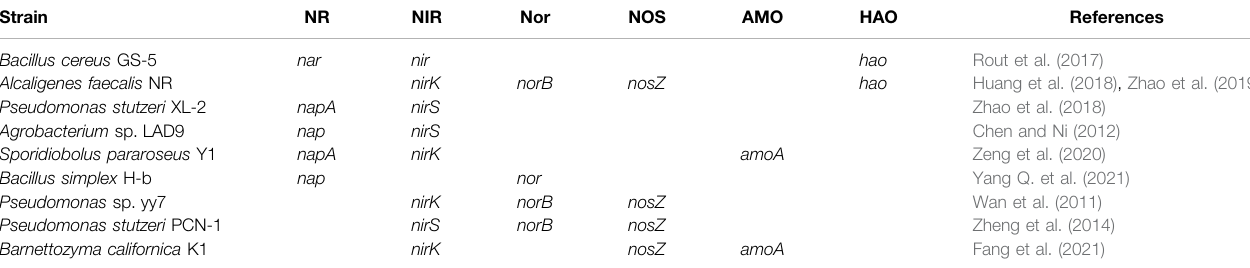
TABLE 2 | Encoding genes of critical enzymes in nitrogen cycle.